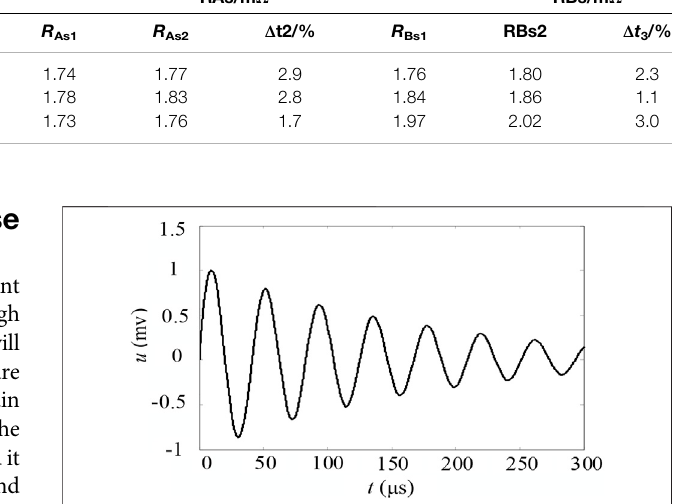
FIGURE 7 | Applied oscillating impulse current ( I max = 127.5 kA, T 1 = 18.4 μ s in the fi rst